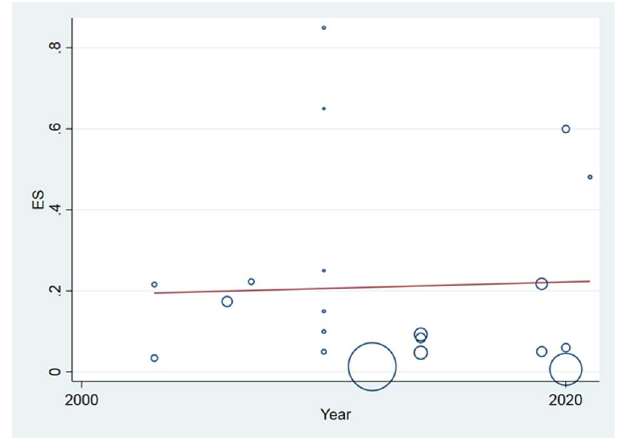
Figure 5. Funnel chart of proportion resistance in the selected studies.